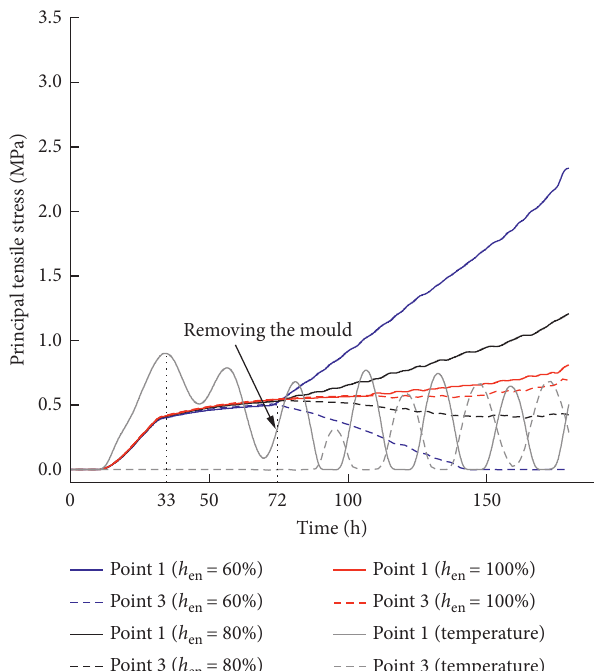
Figure 20: Comparison of time-dependent principal tensile stress caused by temperature and